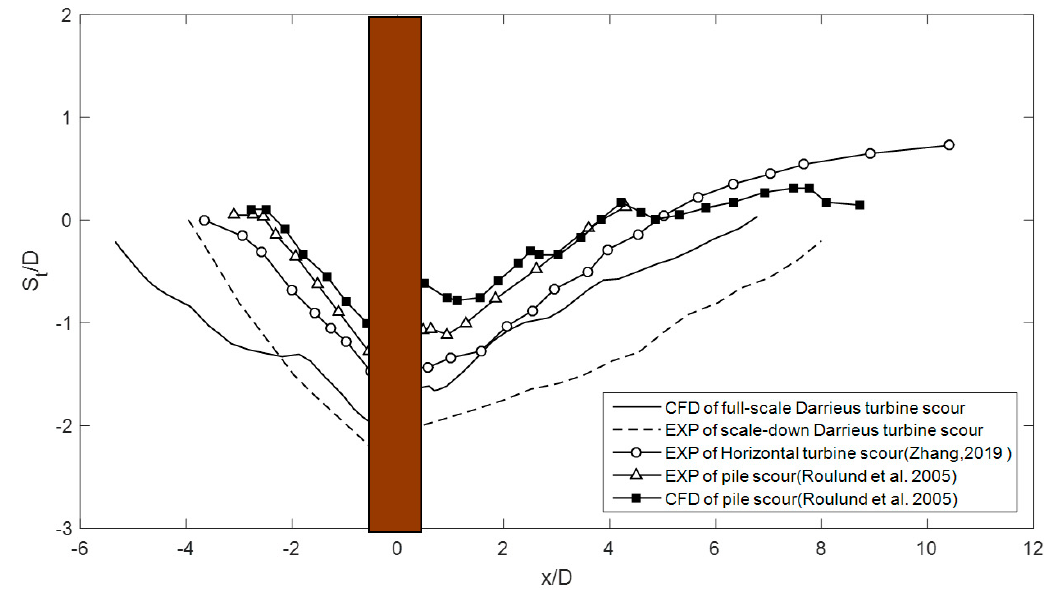
Figure 17. Scour-hole profiles along the upstream–downstream symmetry line.